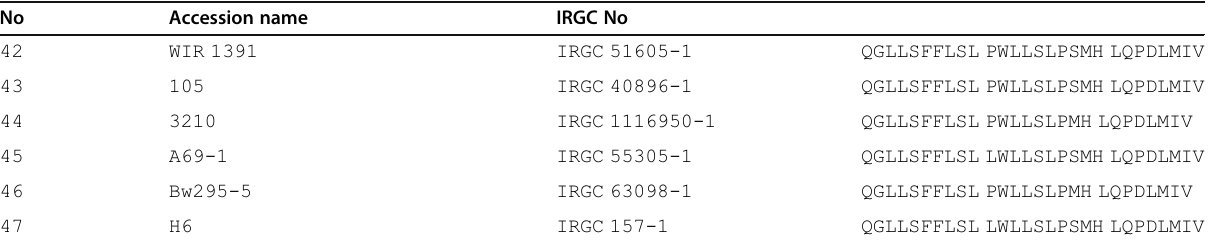
Table 2 Comparison of Pi-ta protein sequences of 47 Sri Lankan rice accessions with wPi-ta ( Tetep , GenBank accession number GQ918486.1) using Clustal W, Bioedit 7.2.5. Highlighted in black are the amino acids that contributed to the resistant phenotype due to the absence of the functional mutation at the 918th amino acid position (Continued)